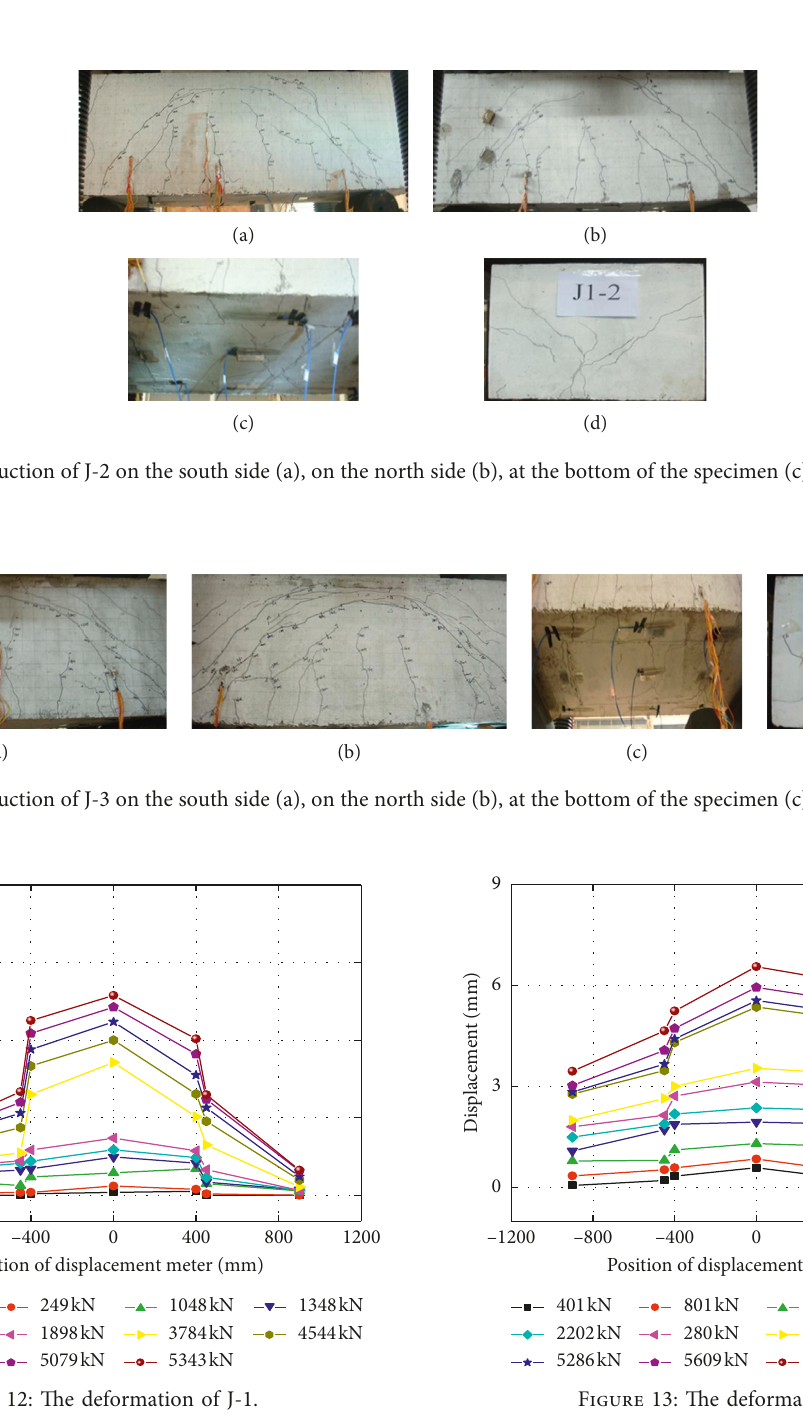
Figure 9: Main destruction of J-1 on the south side (a), on the north side (b), at the bottom of the specimen (c), and on the west side (d).